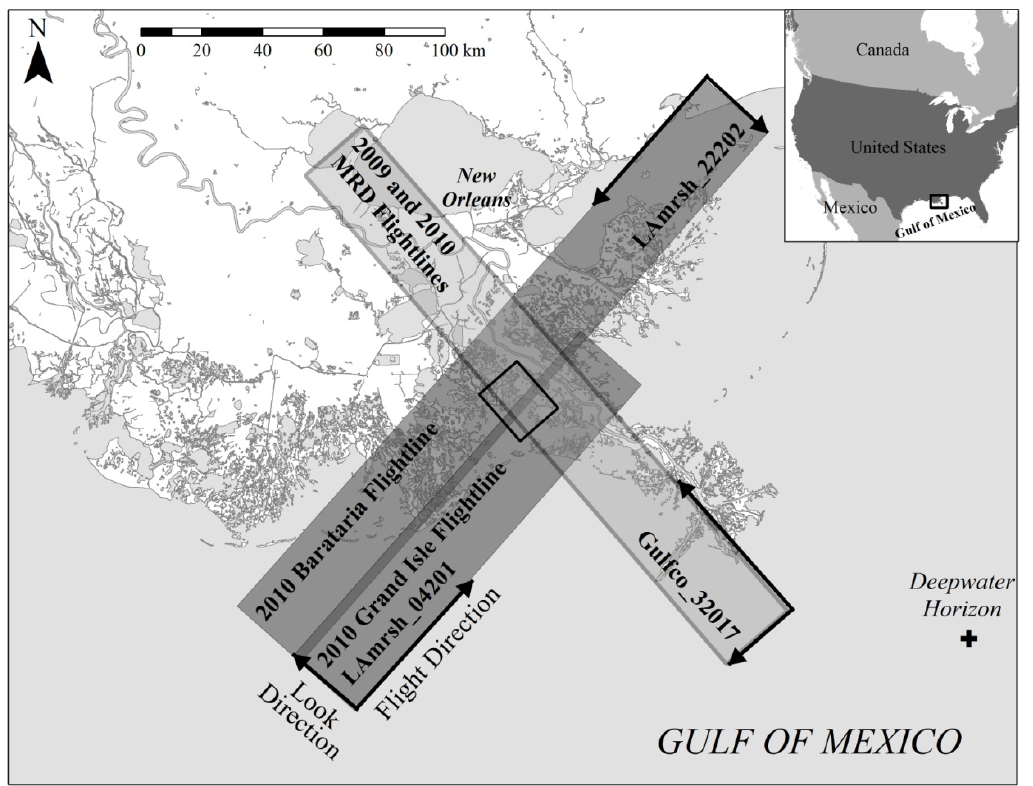
Figure 1. Uninhabited Aerial Vehicle Synthetic Aperture Radar (UAVSAR) flight lines used in this study of the Deepwater Horizon oil spill. The black box in the overlap region is our study